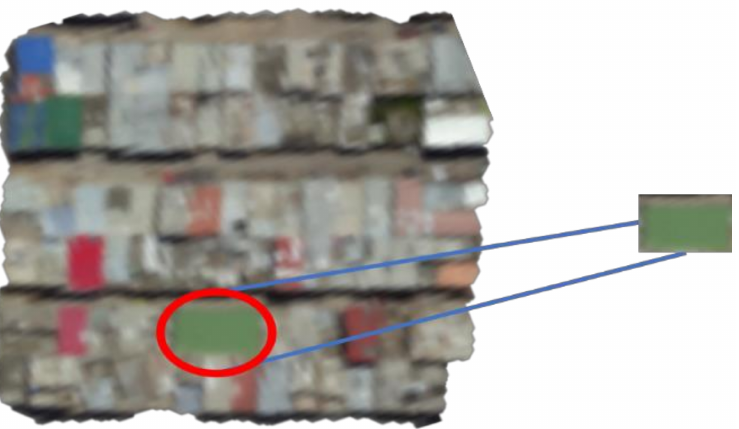
Figure 17. The roof of a building separated from the image.